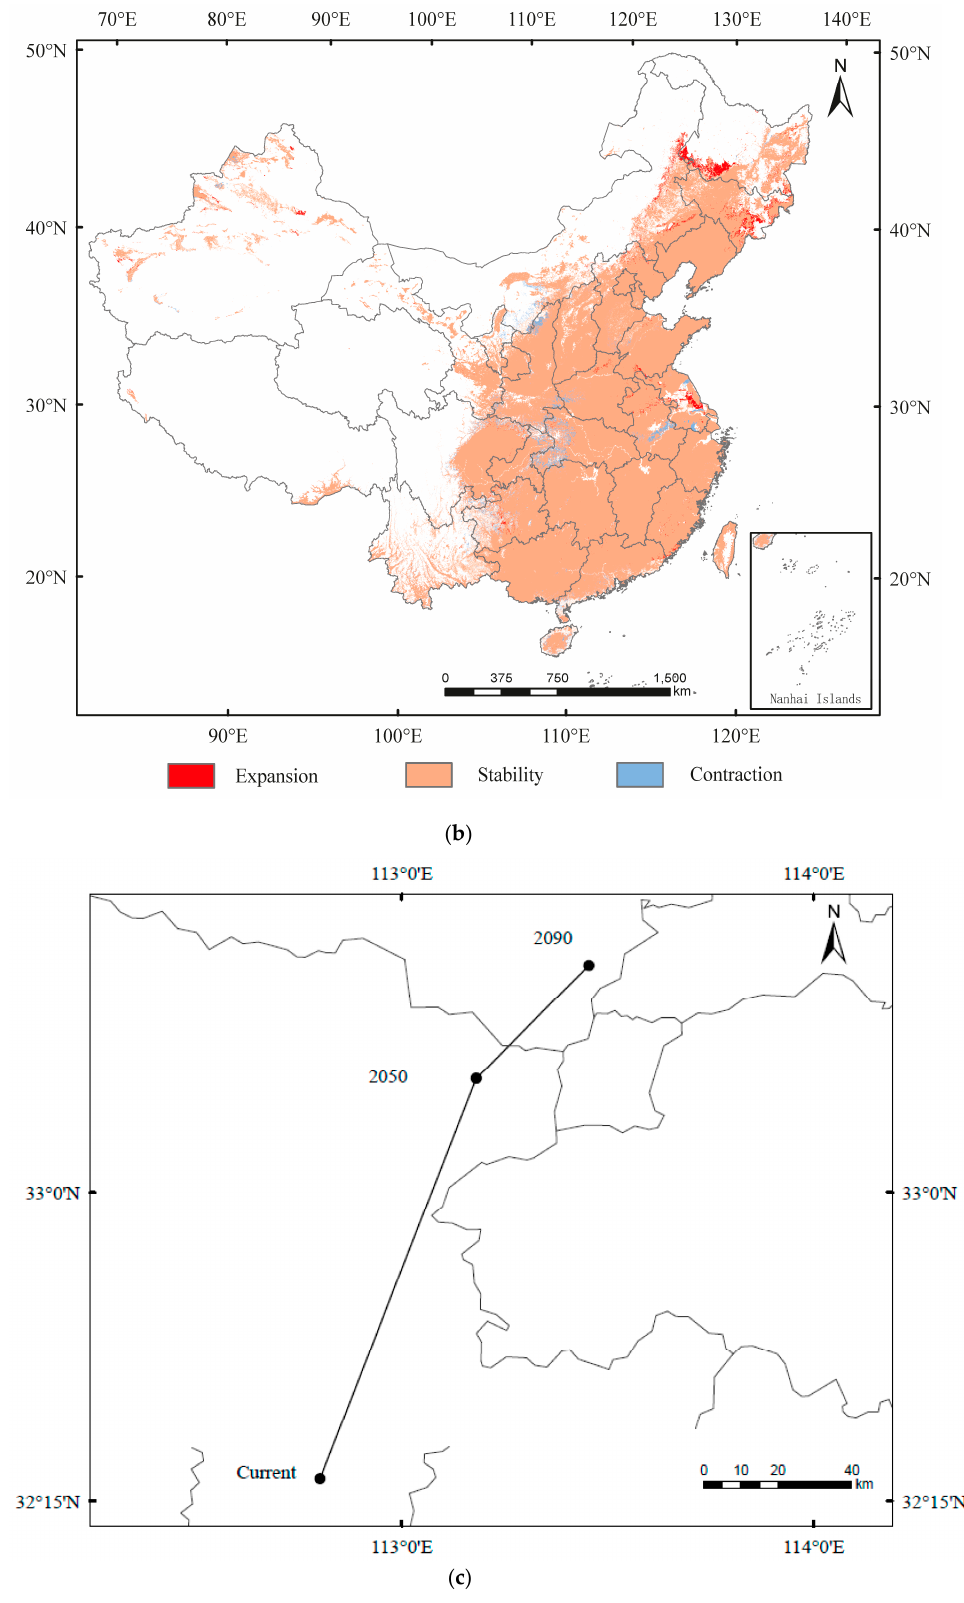
Figure 6. Spatial transfer characteristics of Dastarcus helophoroides in ( a ) current–2050 and ( b ) 2050–2090 stages and ( c ) centroid transfer trajectory in